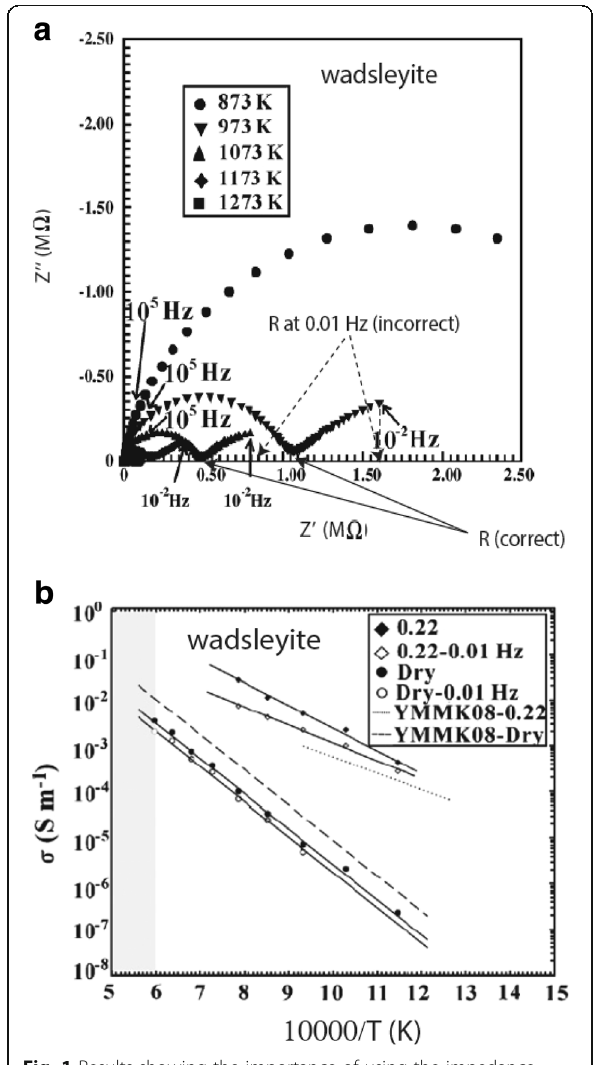
Fig. 1 Results showing the importance of using the impedance spectroscopy (from by Karato and Dai (2009), for wadsleyite). a Typical results of the impedance spectroscopy. The correct measurements should include a wide frequency range showing a half circle, and the intercept of the half circle (shown by R (correct)) of the Z ′ axis provides the estimate of resistivity (from Karato and Dai (2009)). In this figure, we show the results using one frequency (0.01 Hz) as Yoshino (Yoshino et al. 2008, 2006) did. These two methods lead systematic difference in the estimated resistivity. b A comparison of the results from the impedance spectroscopy and from one-frequency (0.01 Hz) measurements (incorrect method) and from the inversion of the impedance spectroscopy. Incorrect one- frequency method leads to the results similar to (Manthilake et al. 2009; Yoshino et al. 2008) (shown by YMMK), but these results show systematic difference from the results from the correct method. Activation enthalpy determined by the incorrect method is systematically lower than the true activation enthalpy. For dry samples where conductivity is due to electron holes, very little difference is seen (a small difference is due to the fact that Yoshino ’ s “ dry ” samples are not truly dry). The difference is larger for samples with larger water content. This leads to the apparent water content dependence of activation